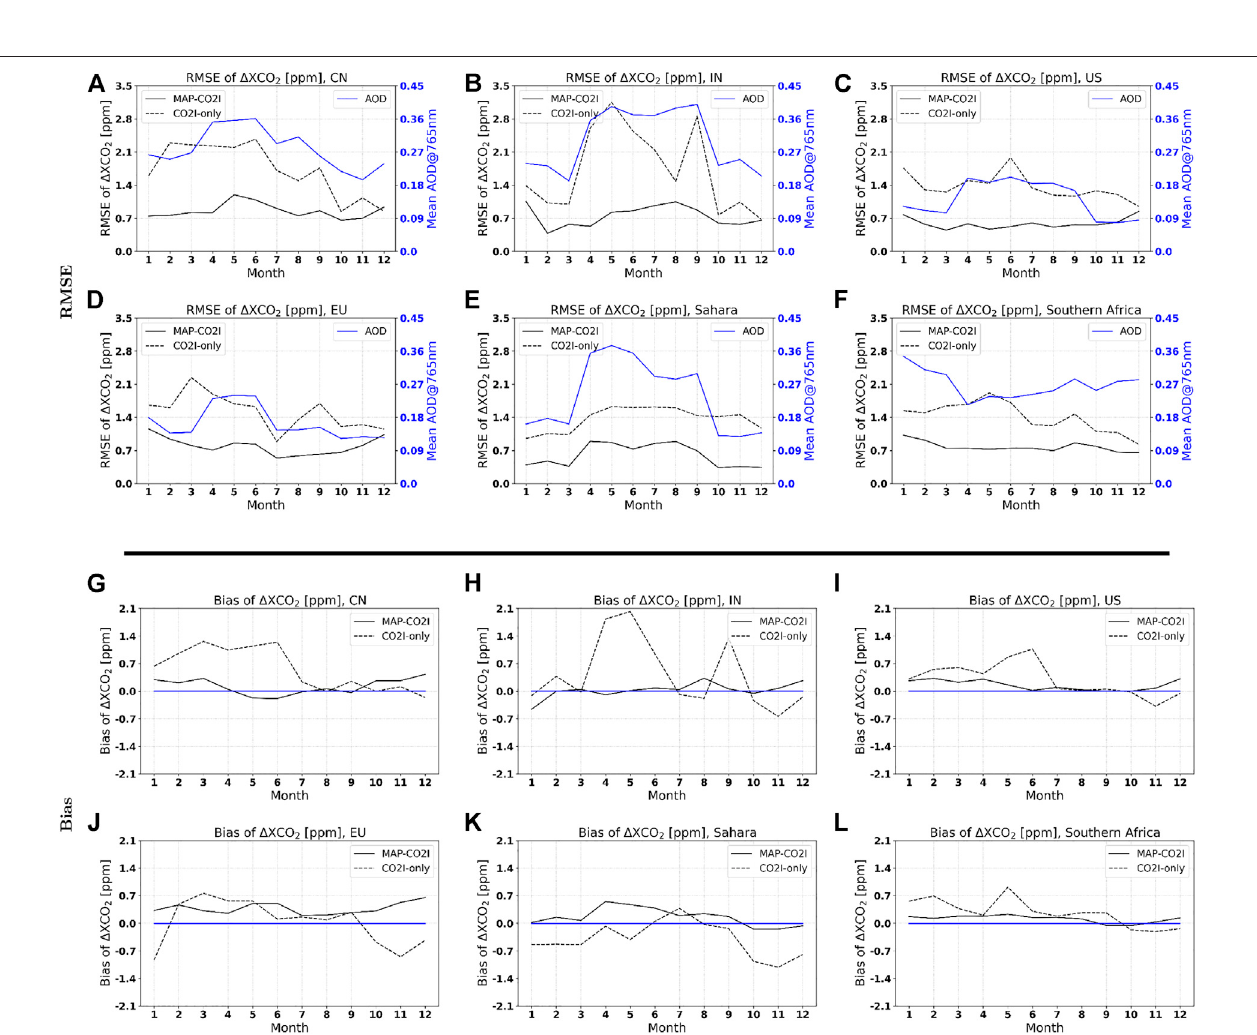
FIGURE9|(A – F) showtheRMSEofXCO 2 retrievals distributedover monthsforChina, India,theUnitedStates, theSahararegionandtheSouthernpartofAfrica, respectively. (G – L) show the bias of XCO 2 retrievals distributed over months for China, India, the United States, the Sahara region and the Southern part of Africa,